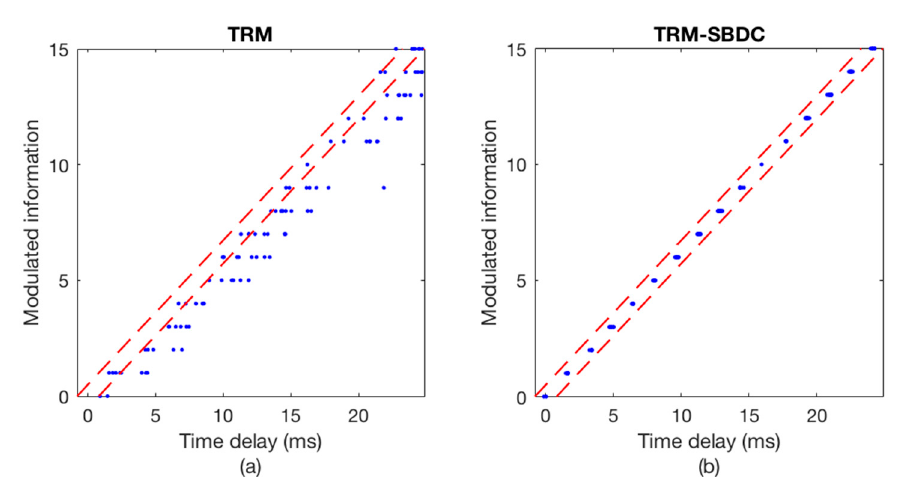
Figure 9. The decoding results. ( a ) TRM; ( b ) TRM-SBDC.